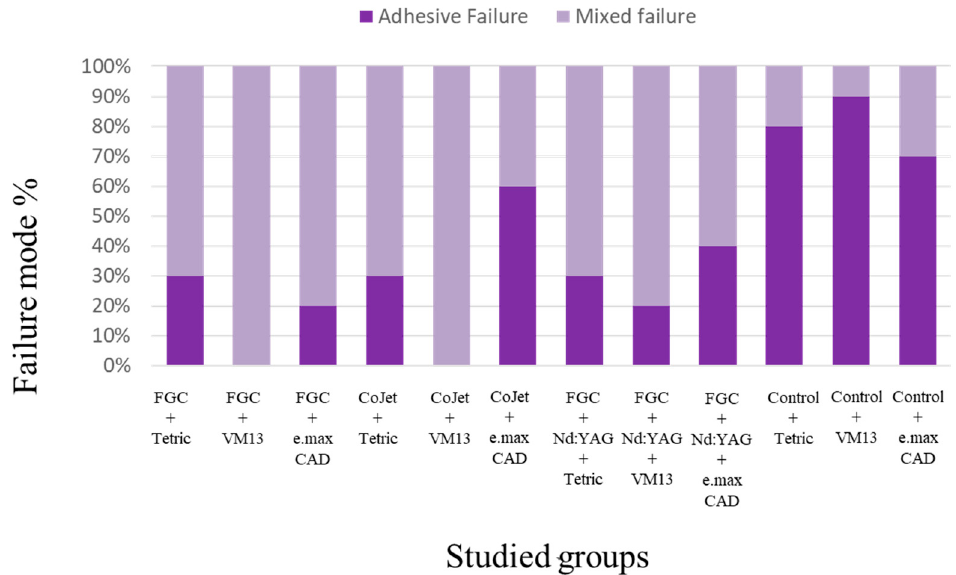
Figure 9. Bar chart showing the failure mode% in all 12 studied groups. The deep purple colour represents the percentage of the adhesive mode of failure in the debonded specimens, while the light purple colour represents the mixed adhesive/cohesive failure.